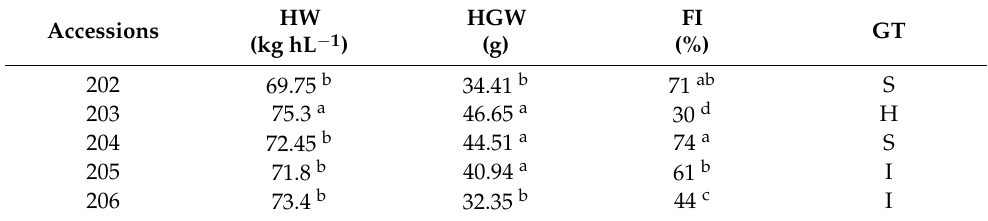
Table 1. Physical characteristics of native corn grain from the Jalisco Highlands, Mexico.